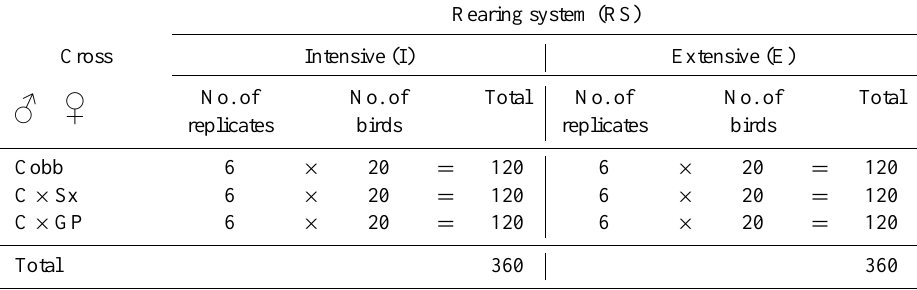
Rearing system Rearing system (RS)